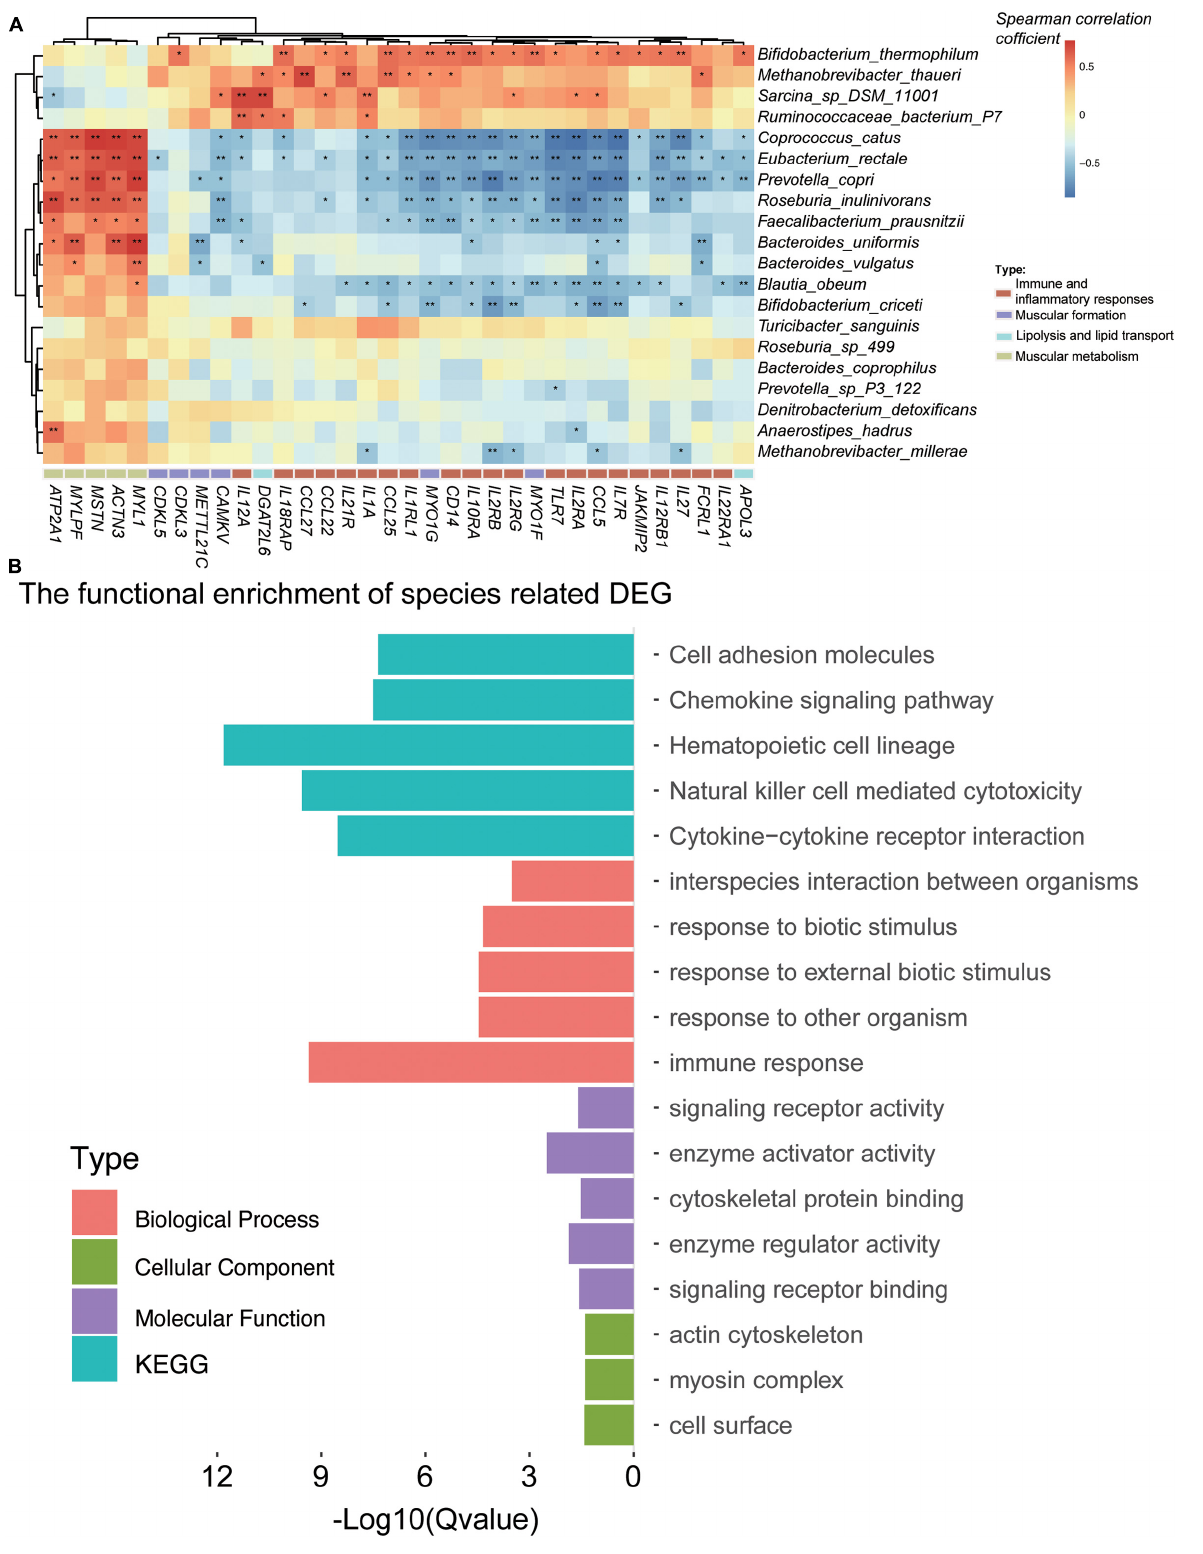
FIGURE 4 | Gut microbiota was associated with the differentially expressed genes (DEGs) for the Angus and Chinese Simmental cattle. In total, 17 species were significantly (the correlation coefficient is greater than 0.6) associated with the DEGs (A) . Function of the DEG-related species (B) .